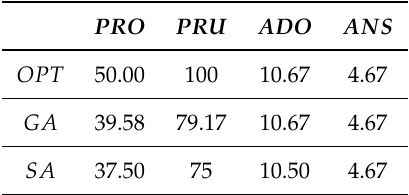
Table 13. Comparison of OPT, GA, and SA for